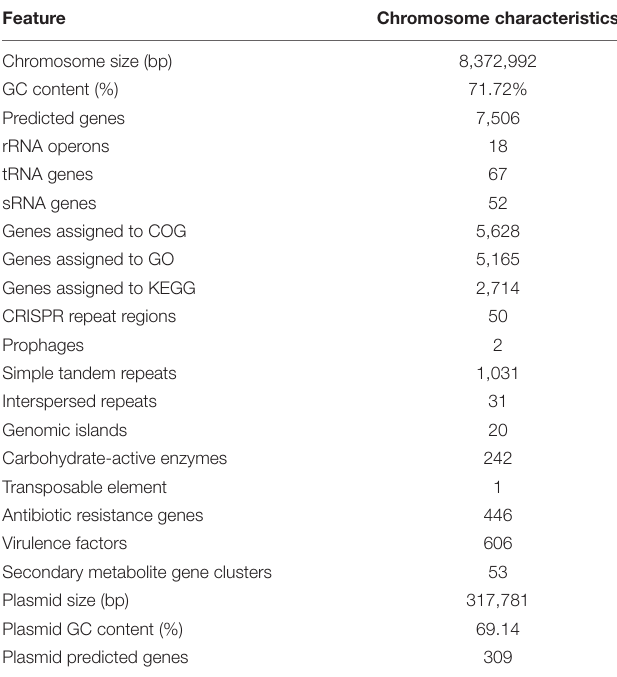
TABLE 3 | Genome features of strain YINM00001.